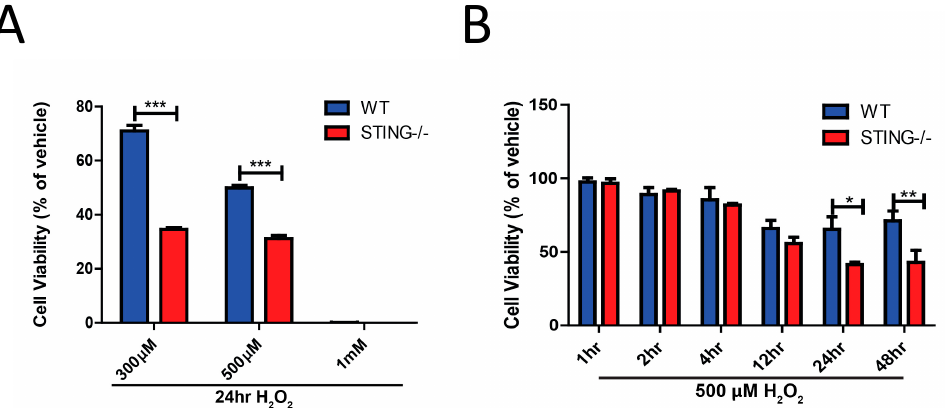
Figure 4. Genetic deletion of STING is detrimental to cellular survival following H 2 O 2 treatment. MTT assay identified reduced cellular viability in STING − / − cells as compared to WT cells following ( A ) dose-dependent H 2 O 2 concentrations for 24 h, ( B ) a time-course of 500 μ M H 2 O 2 concentration ( n = 4). Data represent mean ± SEM, *p < 0.05, **p < 0.01, ***p < 0.0001.